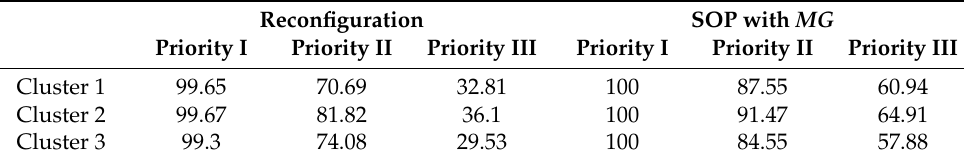
Table 4. Total load restoration rates.